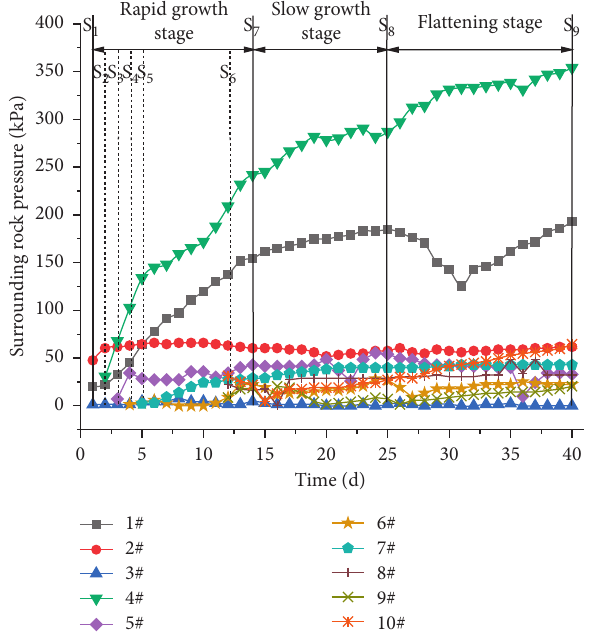
Figure 5: Pressure change curve of surrounding rock of DK- 190+617 miles in early three